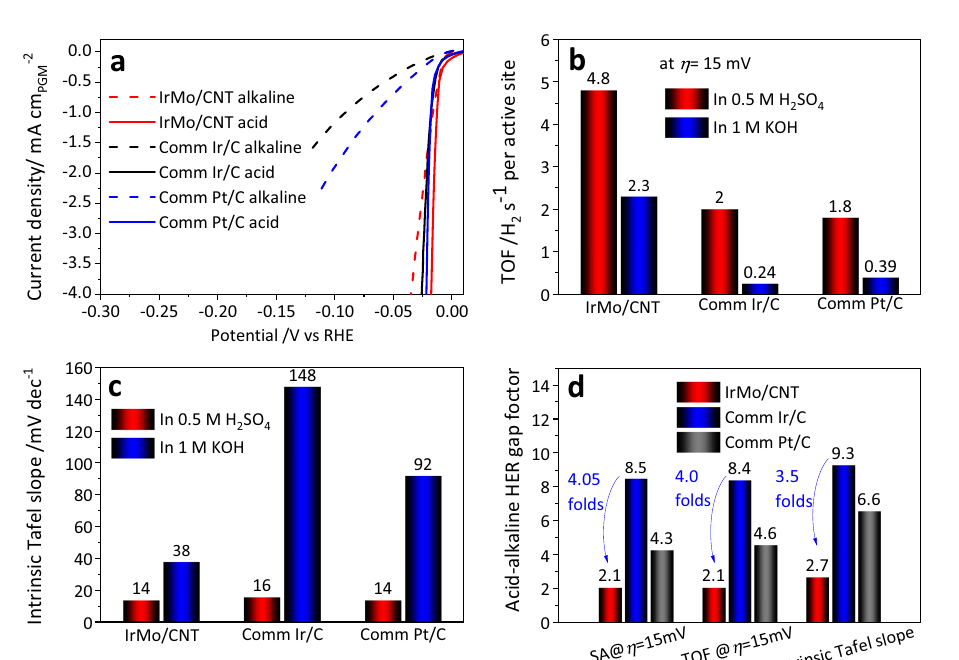
reported ef fi cient HER electrocatalysts at η =50mV in alkaline condition 3,47,48,51,52 . d HER polarization curves in 0.5M H 2 SO 4 . e Comparison of the extracted η 10 from a , d between acidic and alkaline electrolytes. f Comparison of the Tafel slope derived from a , d between acidic and alkaline electrolytes.